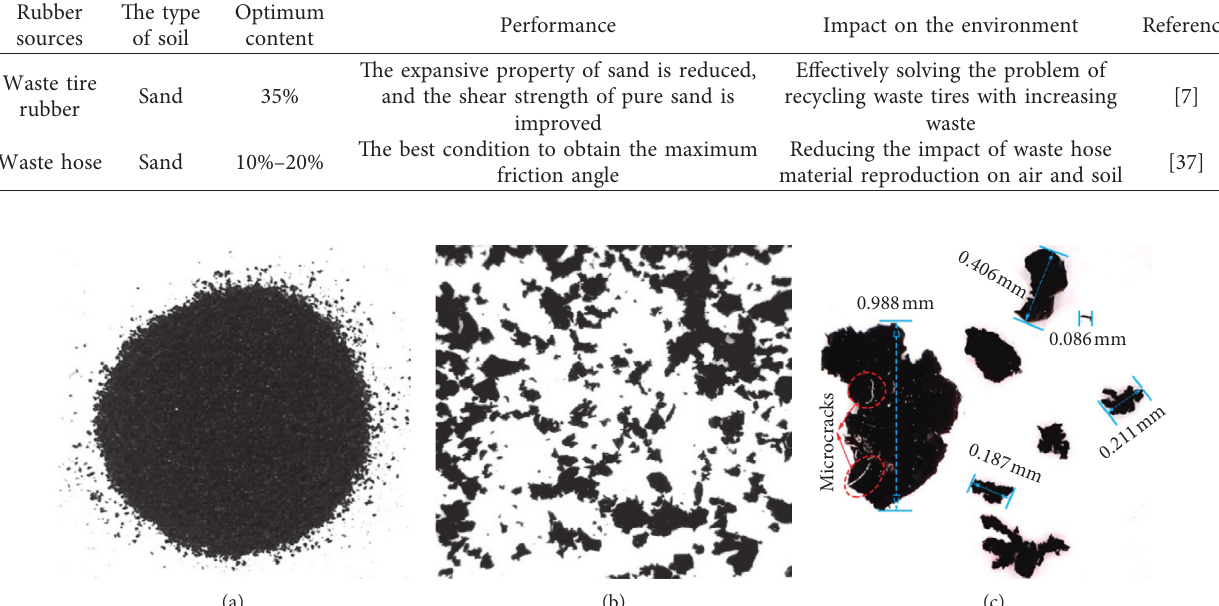
Figure 1: Tire rubber powder with different magnification (modified from [8]). (a) No magnification. (b) 50x magnification. (c) 100x magnification.